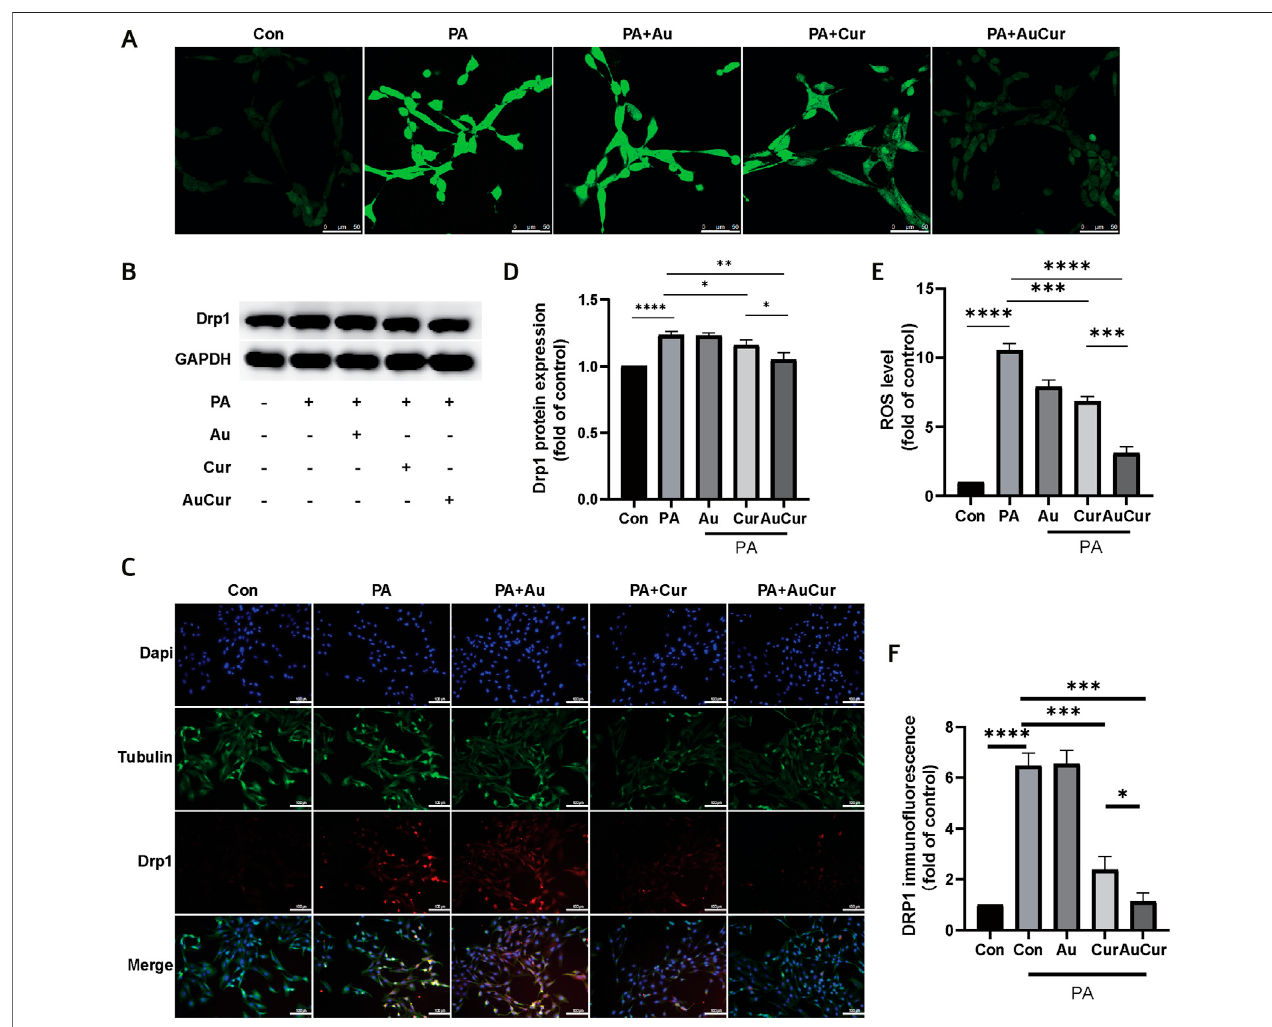
FIGURE 4 | Effects of AuCur on ROS and mitochondria induced by PA action. (A) ROS confocal staining images of Control, PA, PA + Au, PA + Cur, and PA + AuCur.Scale bar:50 μ m. (B) Drp1 expression wasdetected byWB.GAPDH wasused asaninternal reference. (C) Drp1 fl uorescence analysisofControl, PA,PA+Au, PA + Cur, and PA + AuCur groups. Scale bar: 100 μ m. (D) Banding analysis of Drp1. (E) ROS image analysis. (F) Drp1 fl uorescence image analysis. * p < 0.05.